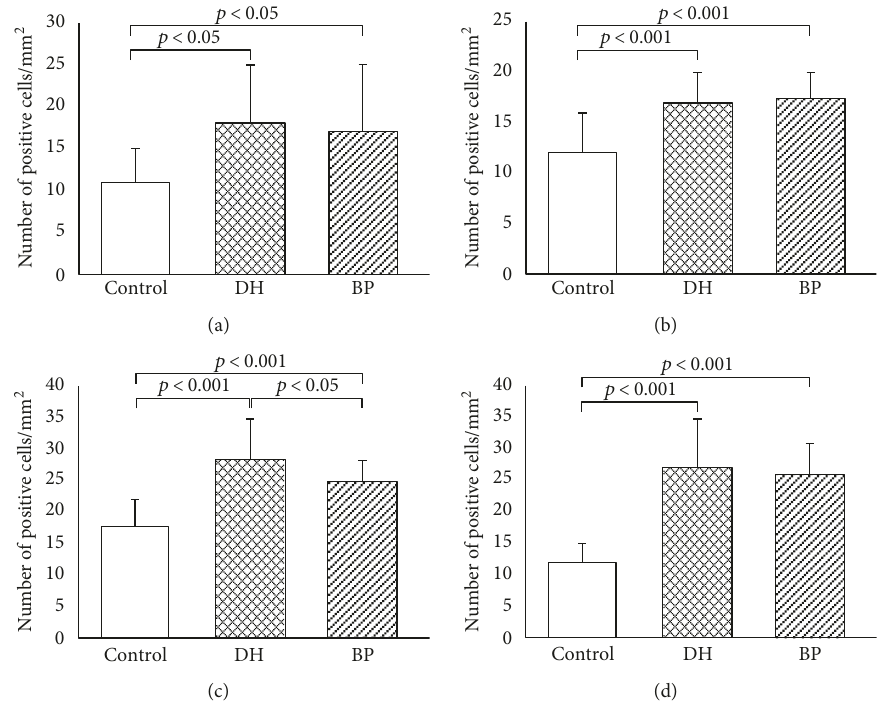
Figure 6: Morphometric analysis of JAK3 (a), STAT2 (b), STAT4 (c), and STAT6 (d) immunoexpression in keratinocytes, evaluated with immunohistochemistry. The results of semiquantitative analysis are expressed as the mean ± SD. Control — normal skin. DH — dermatitis herpetiformis, skin lesions. BP — bullous pemphigoid, skin lesions. The level of signi fi cance is de fi ned where p < 0 05 . JAK3: C versus DH ( p < 0 05 ), C versus BP ( p < 0 05 ), and DH versus BP (NS). STAT2: C versus DH ( p < 0 05 ), C versus BP ( p < 0 05 ), and BP versus DH (NS). STAT4: C versus DH ( p < 0 05 ), C versus BP ( p < 0 05 ), and DH versus BP ( p < 0 05 ). STAT6: C versus DH ( p < 0 05 ), C versus BP ( p < 0 05 ), and DH versus BP (NS).